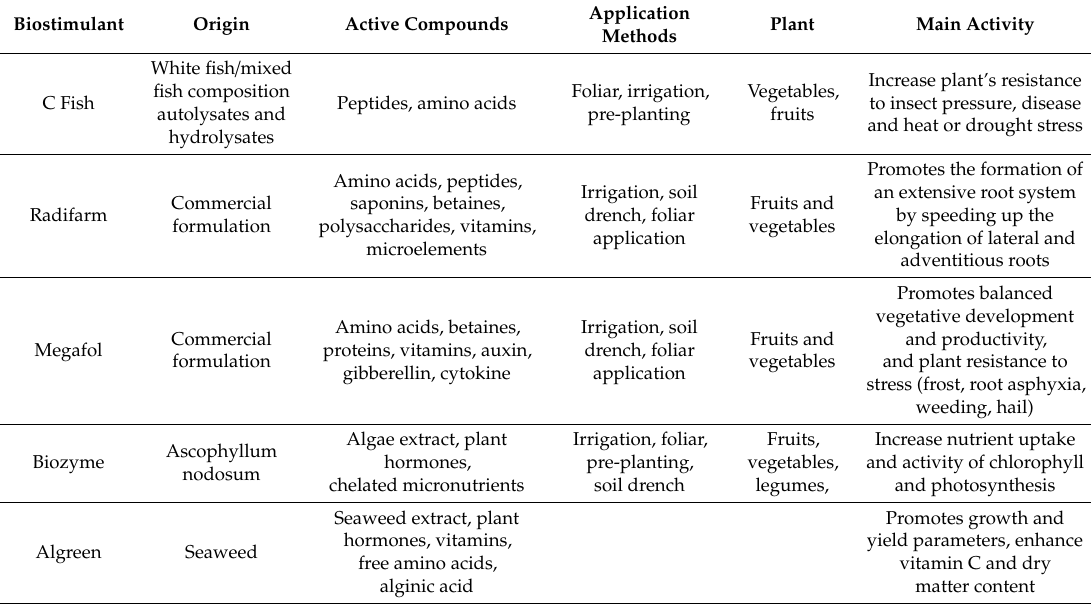
Table 1. Commercially available plant biostimulants, their composition and application strategies